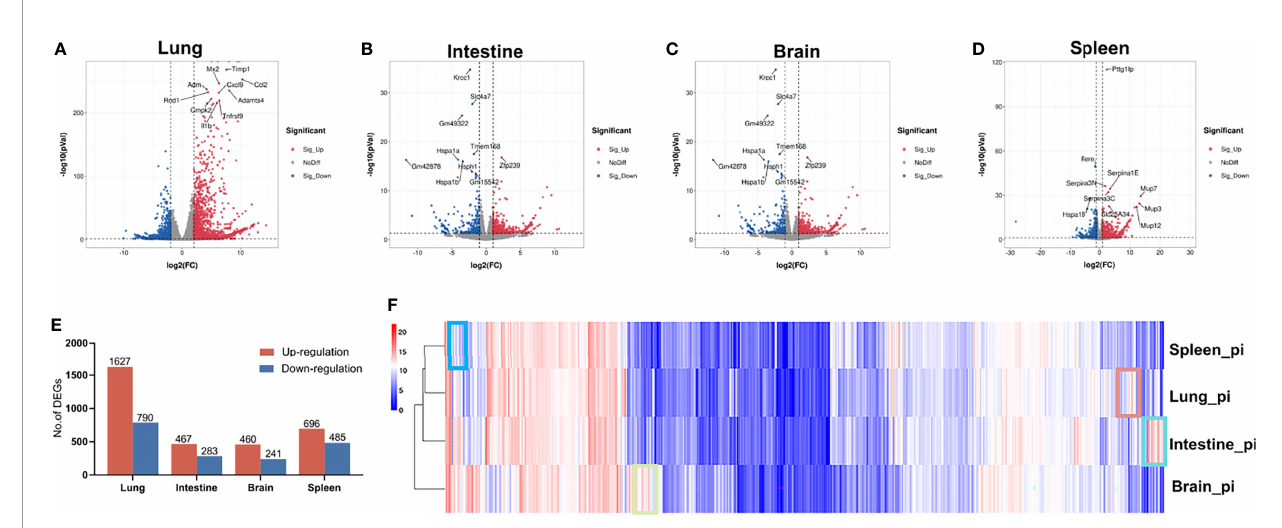
FIGURE 1 | Gene expression patterns in lung, intestine, brain, and spleen of control and RSV-infected mice. (A – D) Volcano plots of DEGs in lung, intestine, brain, and spleen of control and RSV-infected mice. (E) Distribution of up- and down-regulated DEGs in lung, intestine, brain, and spleen. (F) Heatmap of gene expression levels in organs after hierarchical clustering. Selected boxes show organ-speci fi c expressed